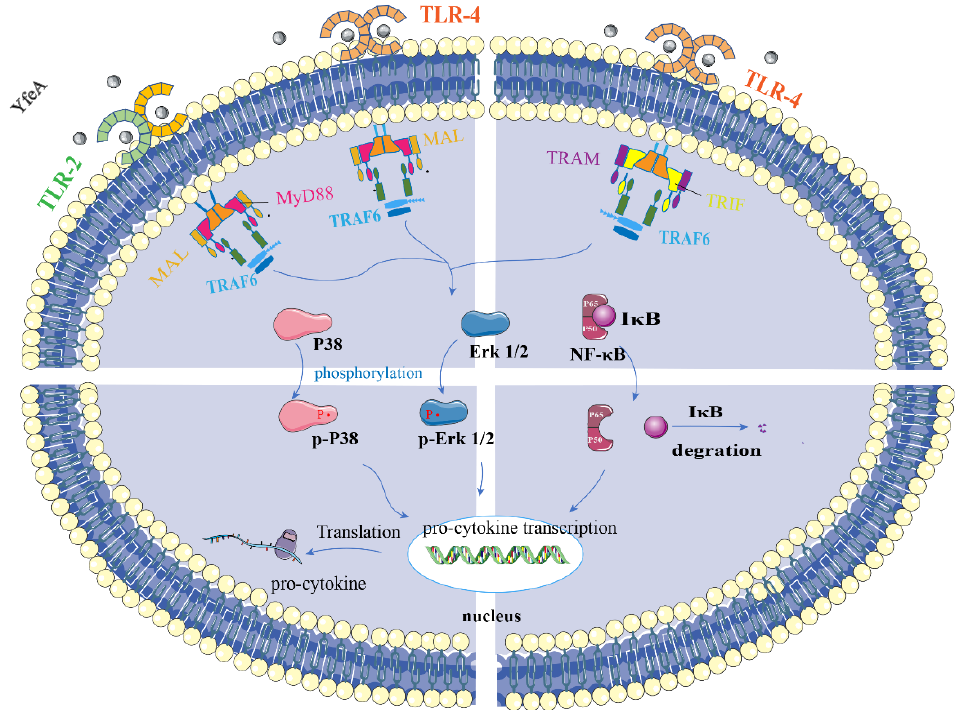
Figure 10. Schematic representation of the signal pathway induced by YfeA based on the above results. YfeA of G. parasuis triggers activation of TLR2 and TLR4, and subsequent recruitment of adaptors MyD88 and TIRAP, which in turn recruits and activates TRAF6 and other downstream signal molecules. The process leads to I κ B proteasomal degradation followed by nuclear translocation of p50 and p65 and phosphorylation of p38 and ERK1/2. The activation of NF ‐κ B and MAP kinase signaling pathways induce transcription and translation of various pro ‐ inflammatory cytokines, including IL ‐ 1 β , IL ‐ 6, and TNF ‐α .